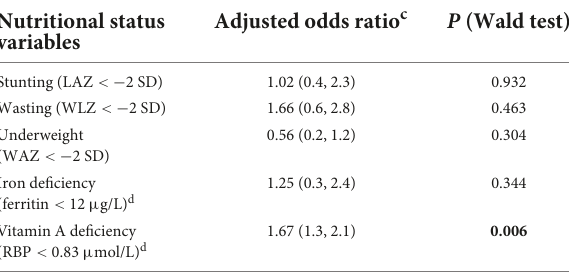
TABLE 4 Multivariate analysis a of odds for maternal symptom recall association with infant biological nutritional status in the COVA study. b